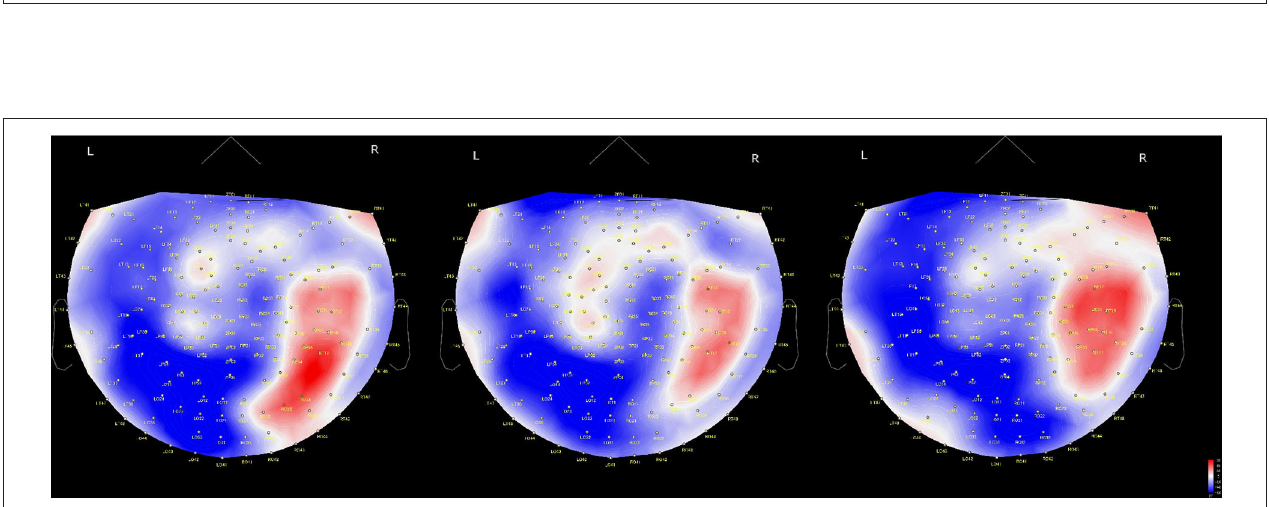
FIGURE 3 | Time-dependent changes in functional connections. The top row shows morally bad judgment conditions and bottom row shows morally good judgment conditions. The left column shows 62–140 ms, middle column shows 122–180ms, and right column shows 182–304ms. L indicates left hemisphere and R indicates right hemisphere. MEG channels are placed on RF (right frontal area), RT (right temporal area), RC (right central area), RP (right parietal area), RO (right occipital area), LO (left occipital area), LP (left parietal area), LC (left central area), LT (left temporal area), and LF (left frontal area). The value denotes the correlation coefficient r.